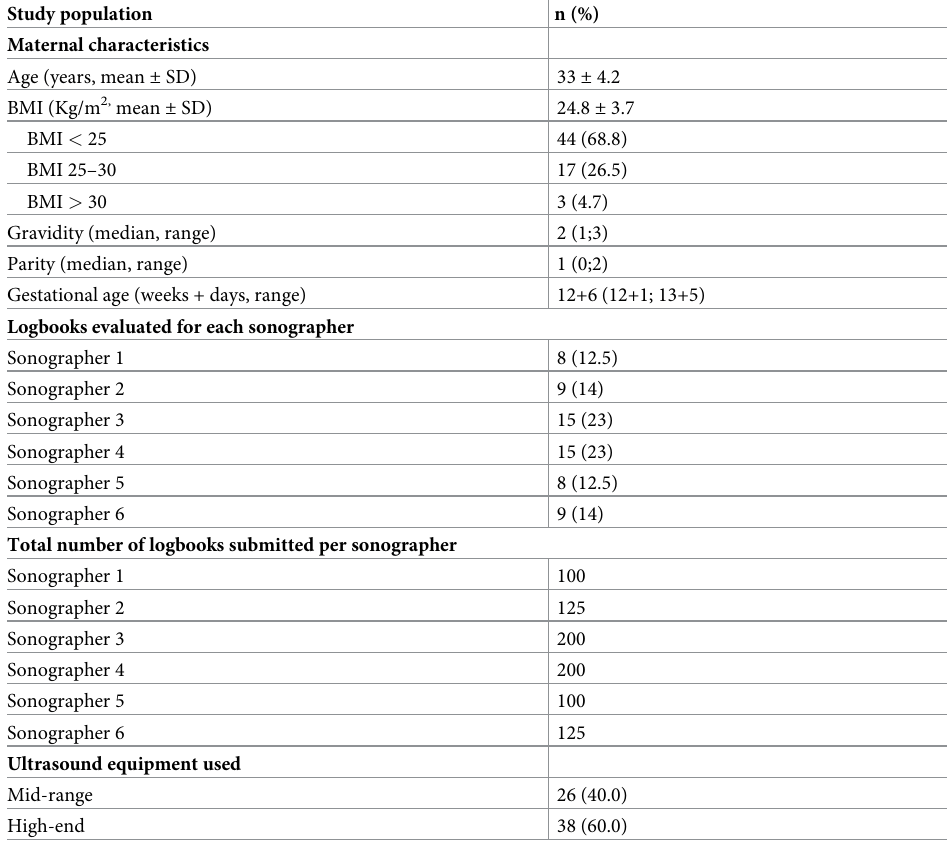
Table 2. Study population (n =